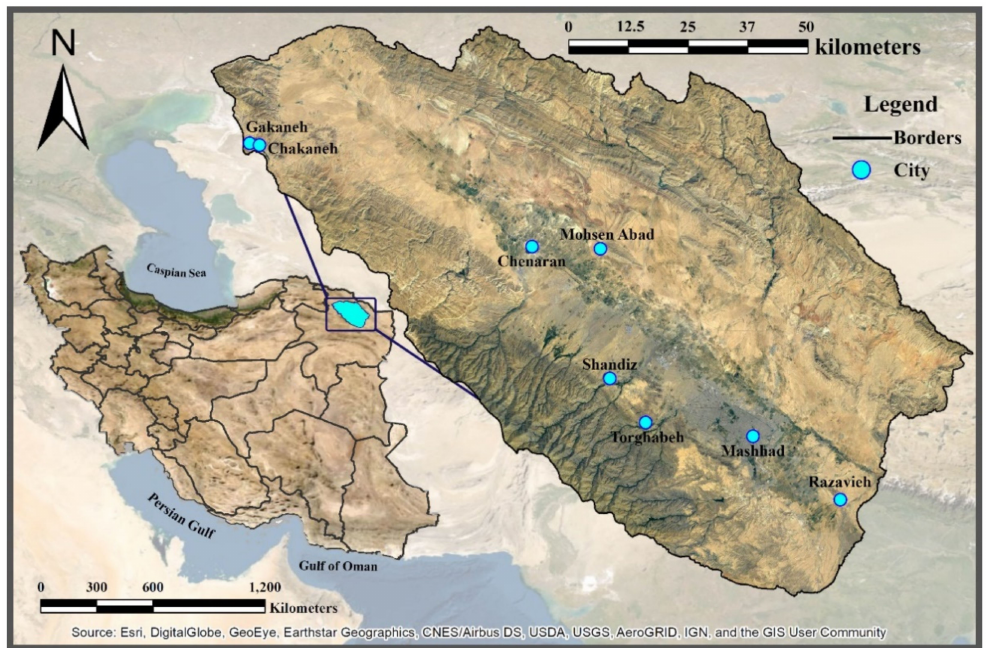
Figure 2. Mashhad Plain Basin in Northeastern